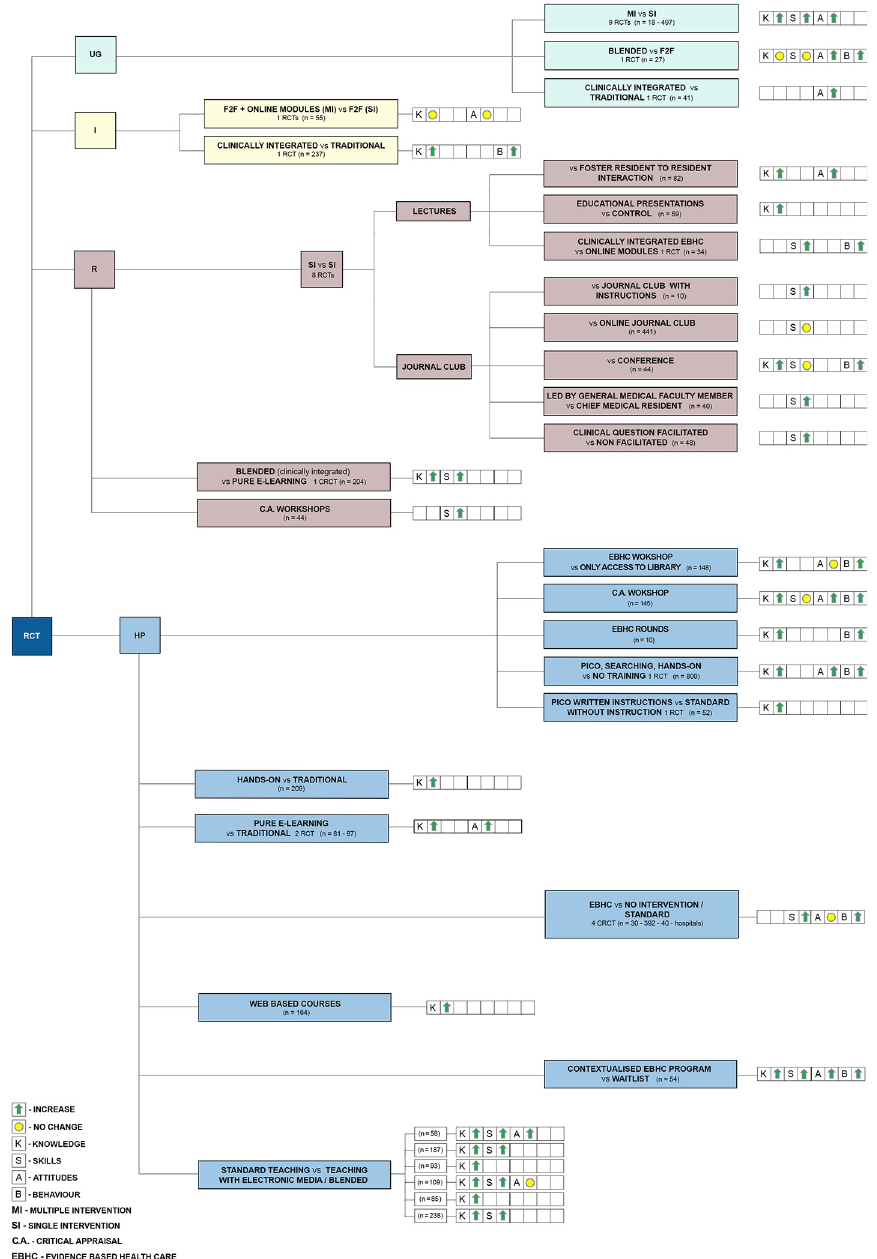
Fig 4. Illustrative display of the likely impact of different teaching approaches at different medical education levels–summary from RCT. HP–health professionals, I–interns, R–residents, RCT- randomised controlled trial, UG– undergraduates; Explanation of the coloured symbols used are provided on the